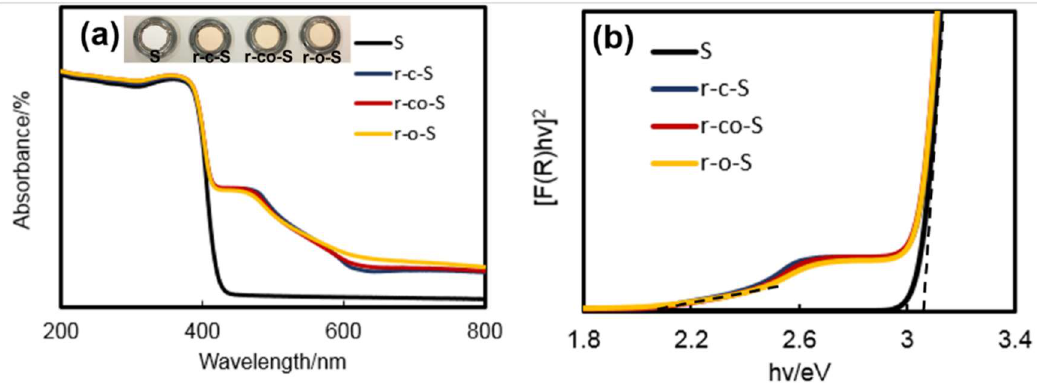
Figure 6. ( a ) Diffuse reflectance spectra and ( b ) Tauc plots with Kubelka–Munk function derived from reflection spectra of titania (ST-G2) and FCP-loaded titania.